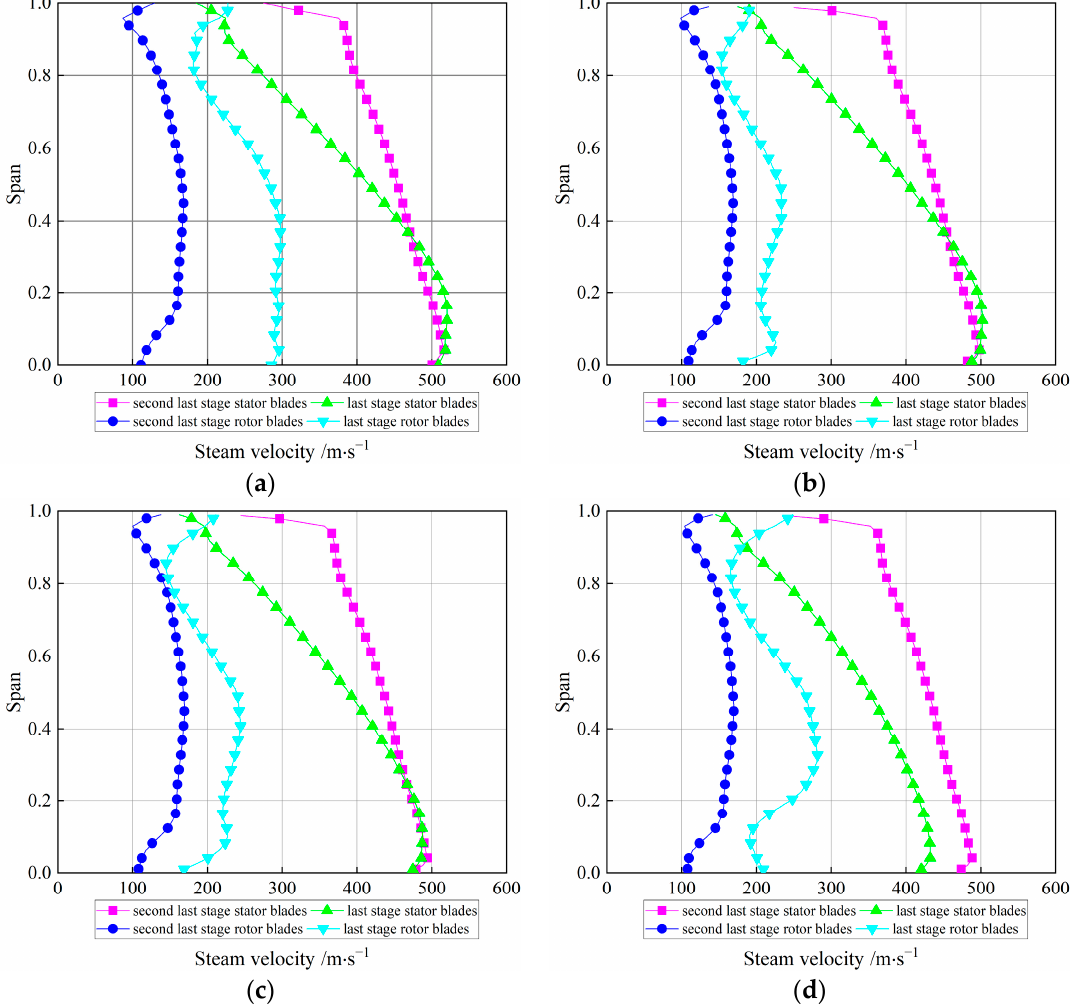
Figure 6. Steam velocity under different working conditions. ( a – d ), respectively, represent 100%, 50%, 40%, and 30% THA.